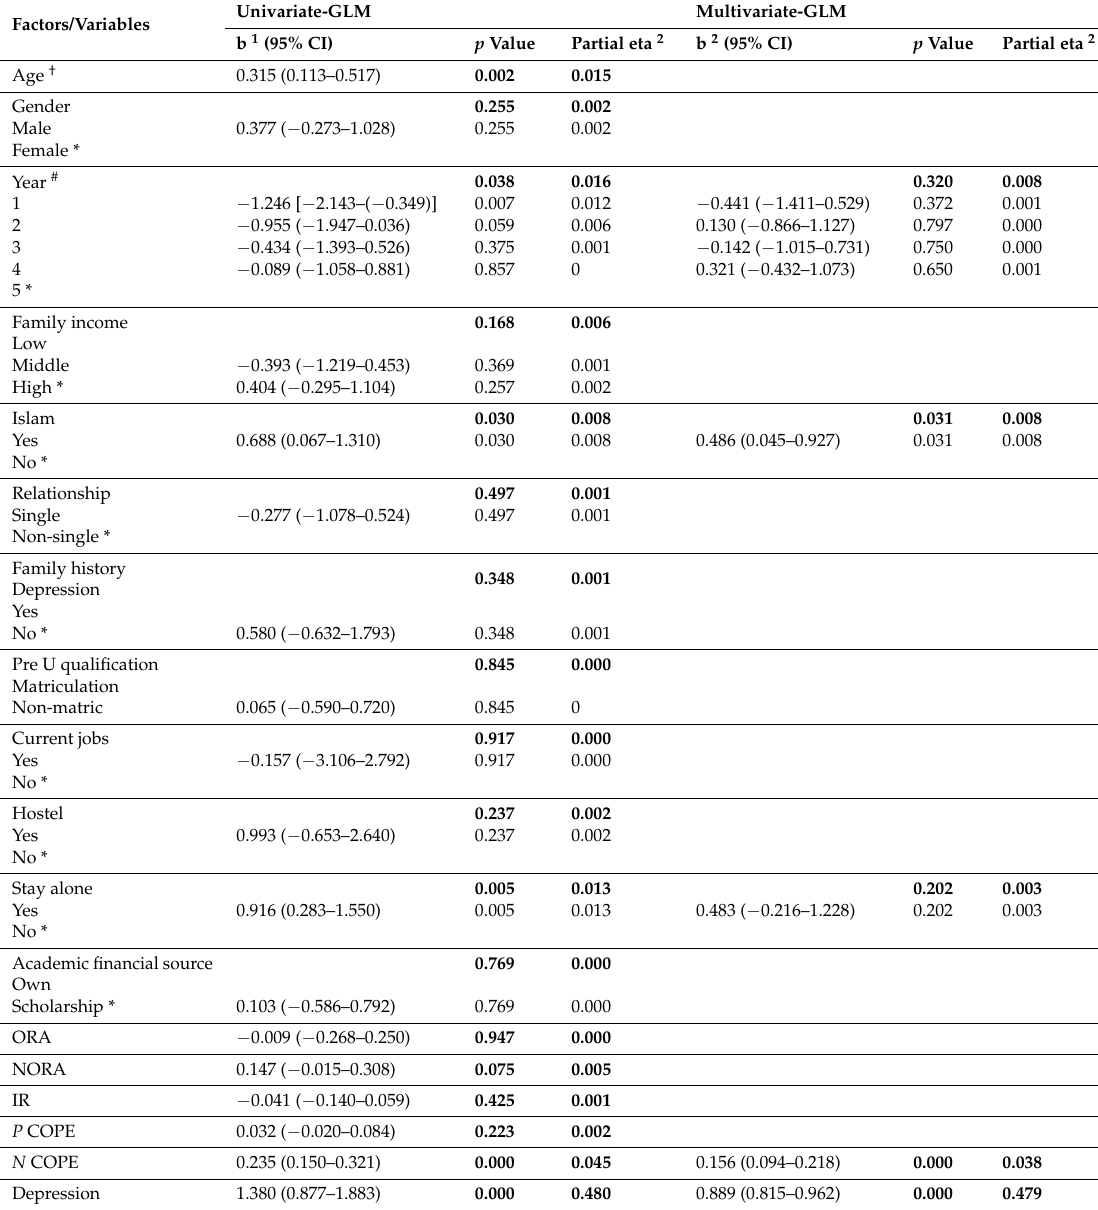
Table 6. General Linear Model on factors associated with anxiety based on ( n =